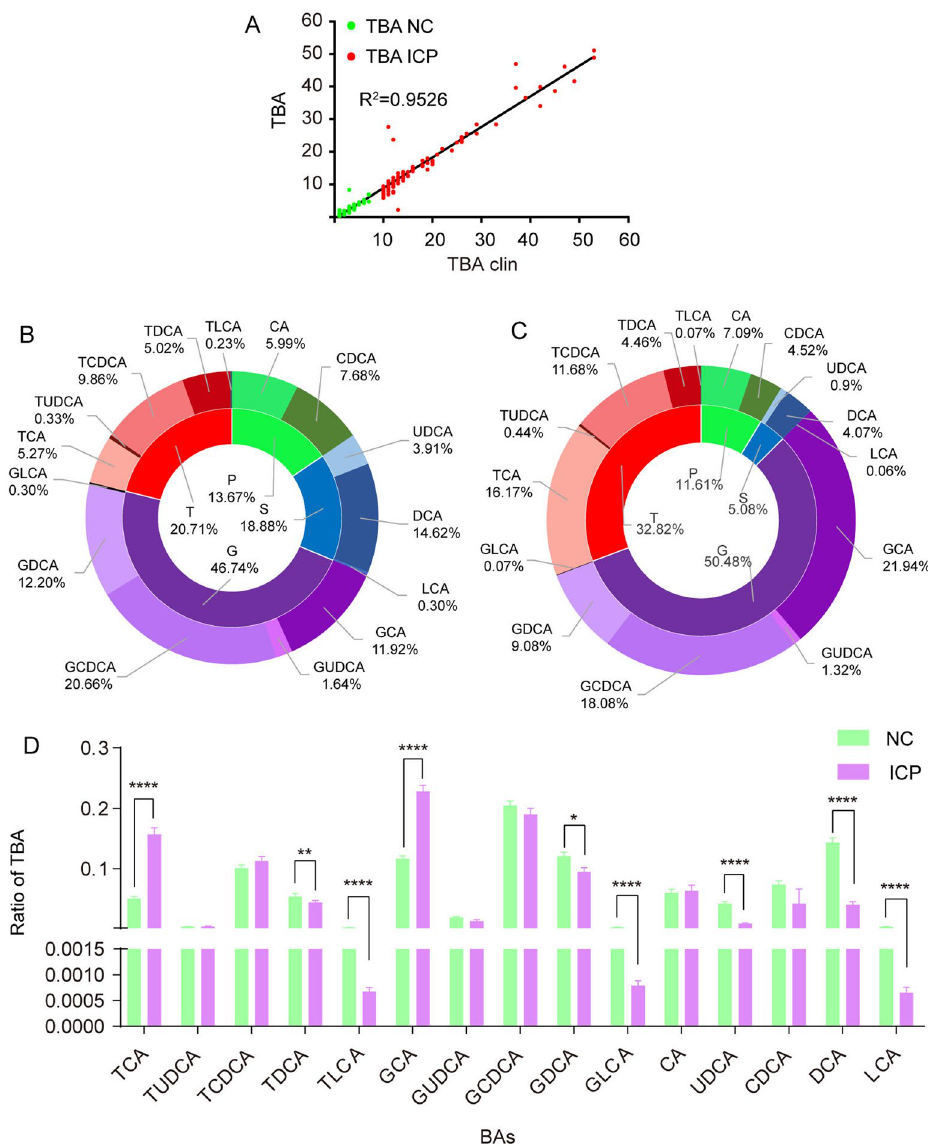
Figure 2. Correlation of TBA detected by cycling enzymatic assay and LC ‒ MS in all the participants. The green and red dots represent normal pregnant women and women with ICP, respectively ( A ). Pie charts show the percentage variation of BA individuals in TBA between NC ( B ) and ICP patients ( C ), (P: primary BAs, S: secondary BAs, G: glycine conjugated BAs, T: taurine conjugated BAs). T test of BA metabolism changes compared with the normal control ( D ). * P < 0.05; ** P < 0.01; **** P <